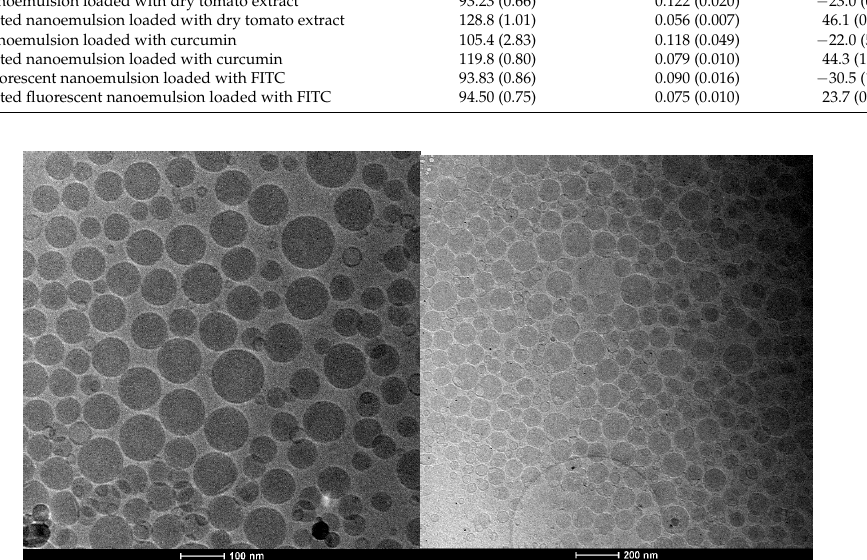
Figure 1. Cryo-TEM projection images of dryTom-Ne ( left ) and dryTom-Ne-CT ( right ).